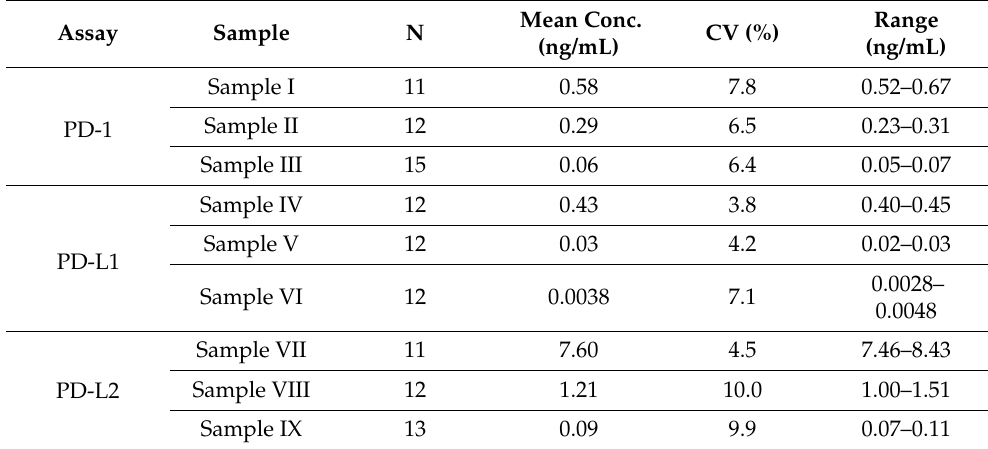
Table 1. Results for intra-assay imprecision